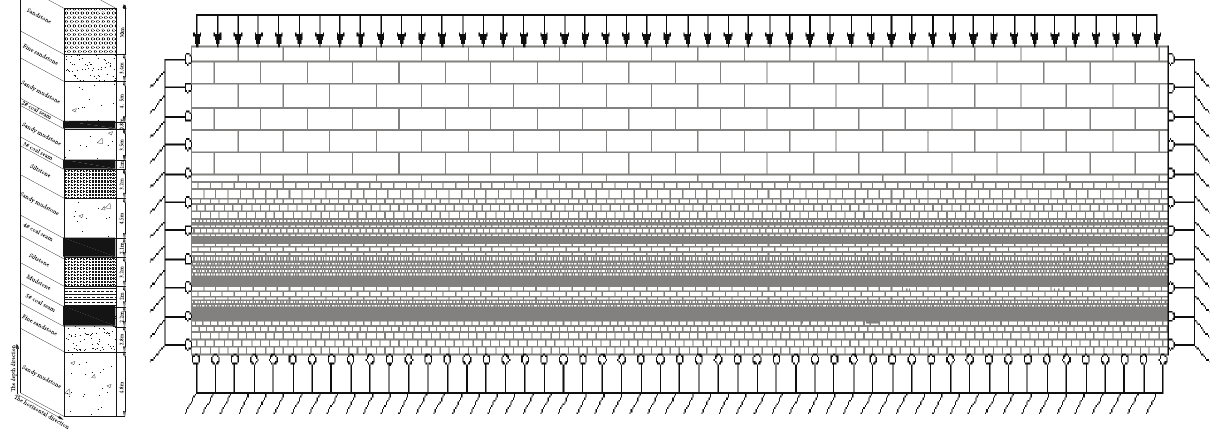
Figure 10: Strata distribution of numerical simulation. Table 1: Mechanical parameters of the